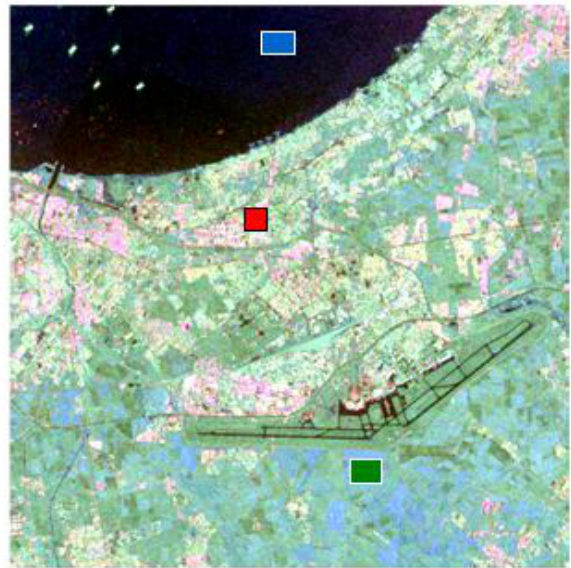
Figure 6: The selected regions of interests to generate the polarimetric signatures in full and compact modes. The three outlined areas the urban (double-bounce scattering), grass (surface scattering), and sea (Bragg surface) regions over which the polarimetric signatures are examined. the covariance matrix. The components of the scattering matrix are analyzed to assign each pixel to one of three scattering categories of the model: surface, double-bounce scattering, and volume scattering. The mechanisms are a